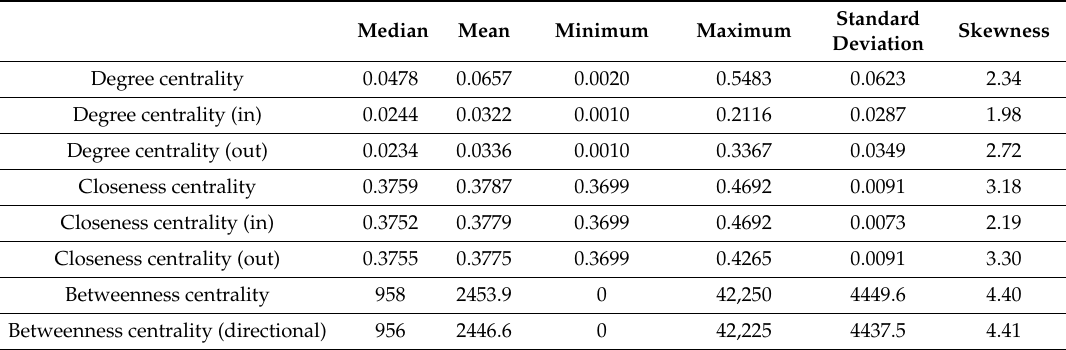
Table 4. Main statistics for graph theory